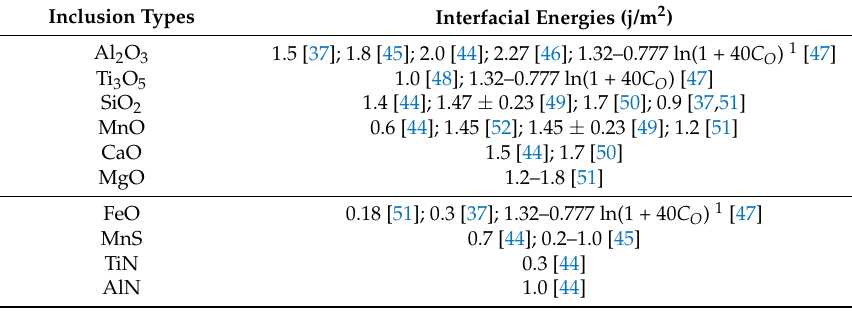
Table 1. The interfacial energies between inclusions and liquid Fe-based